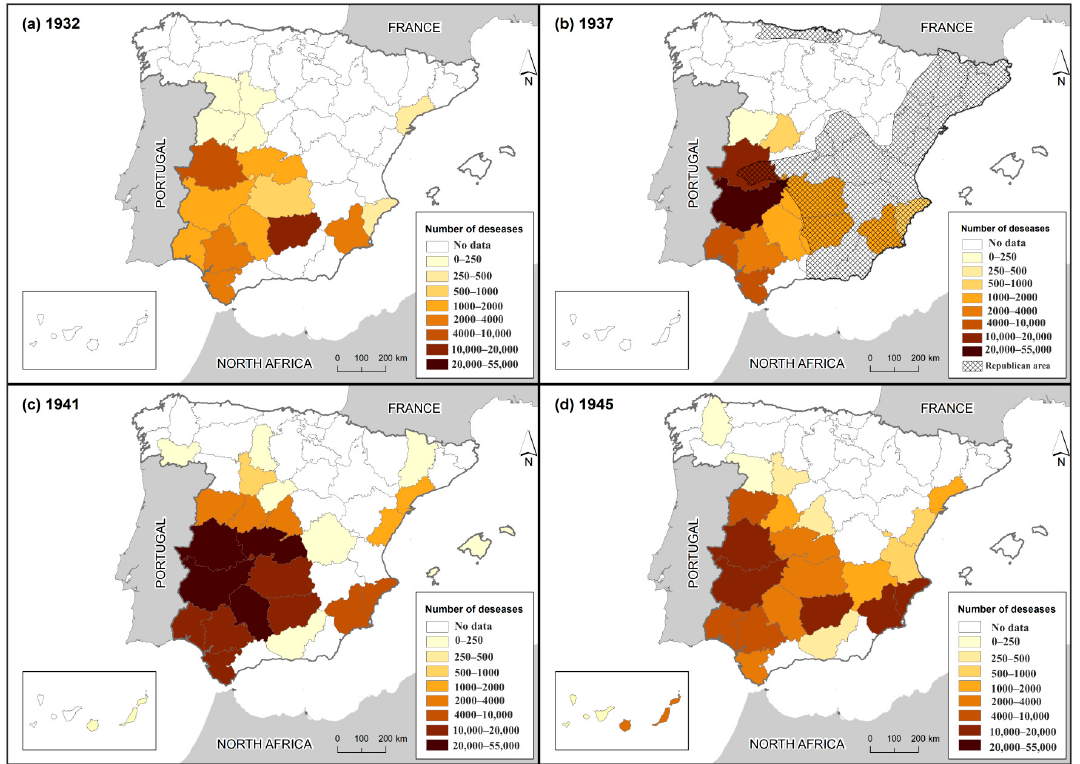
Figure 9. Spatial distribution of number of infected people assisted in each Spanish province in antimalarial dispensaries in the period 1932–1945: ( a ) 1932; ( b ) 1937; ( c ) 1941; and ( d ) 1945. The year 1937 includes the approximate location of the war fronts occupied by the republican side (cross-hatched area) and the national side (without cross-hatch) in March 1937.